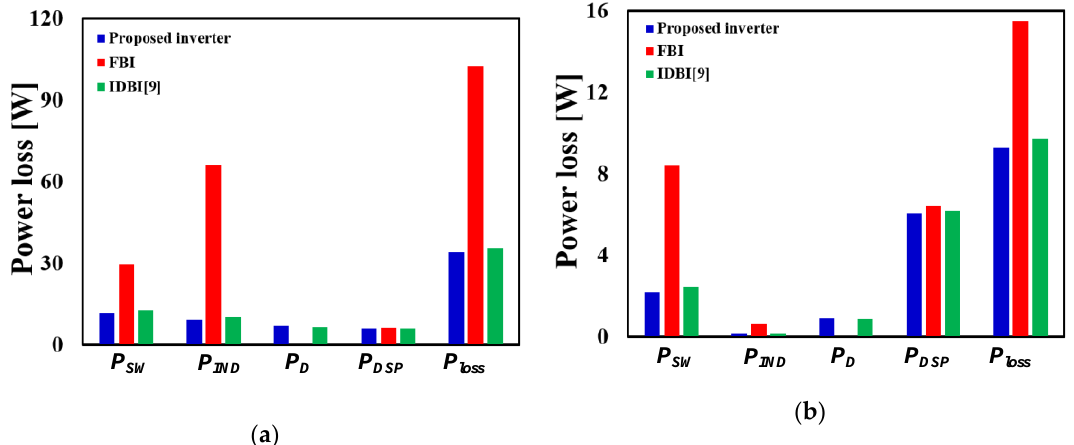
Figure 12. Power losses in the experimental inverters at ( a ) P o = 2 kW and ( b ) P o = 150W: calculated using PSPICE at V in = 400 V DC , V grid = 220 V AC / 60 Hz, f s = 20 kHz, and Q o = 0 VAR.